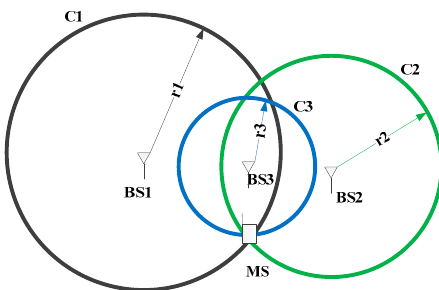
Figure 3. The MS location estimation based on the ideal TOA trilateration in the specific case.